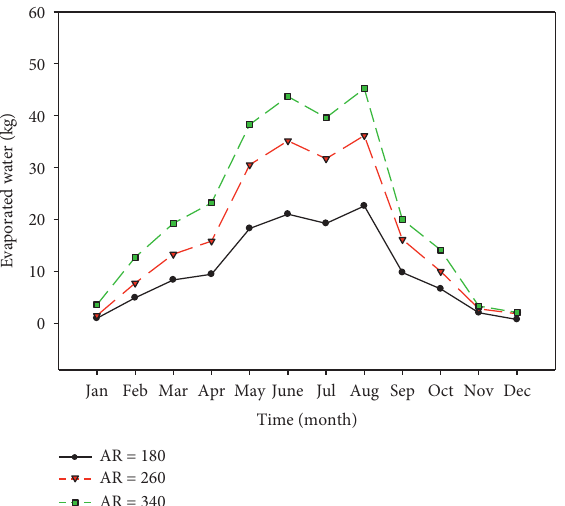
Figure 16: Effect of aspect ratio on monthly evaporated water for reactor inclined at 1 ° , Re � 9000, and water depth �